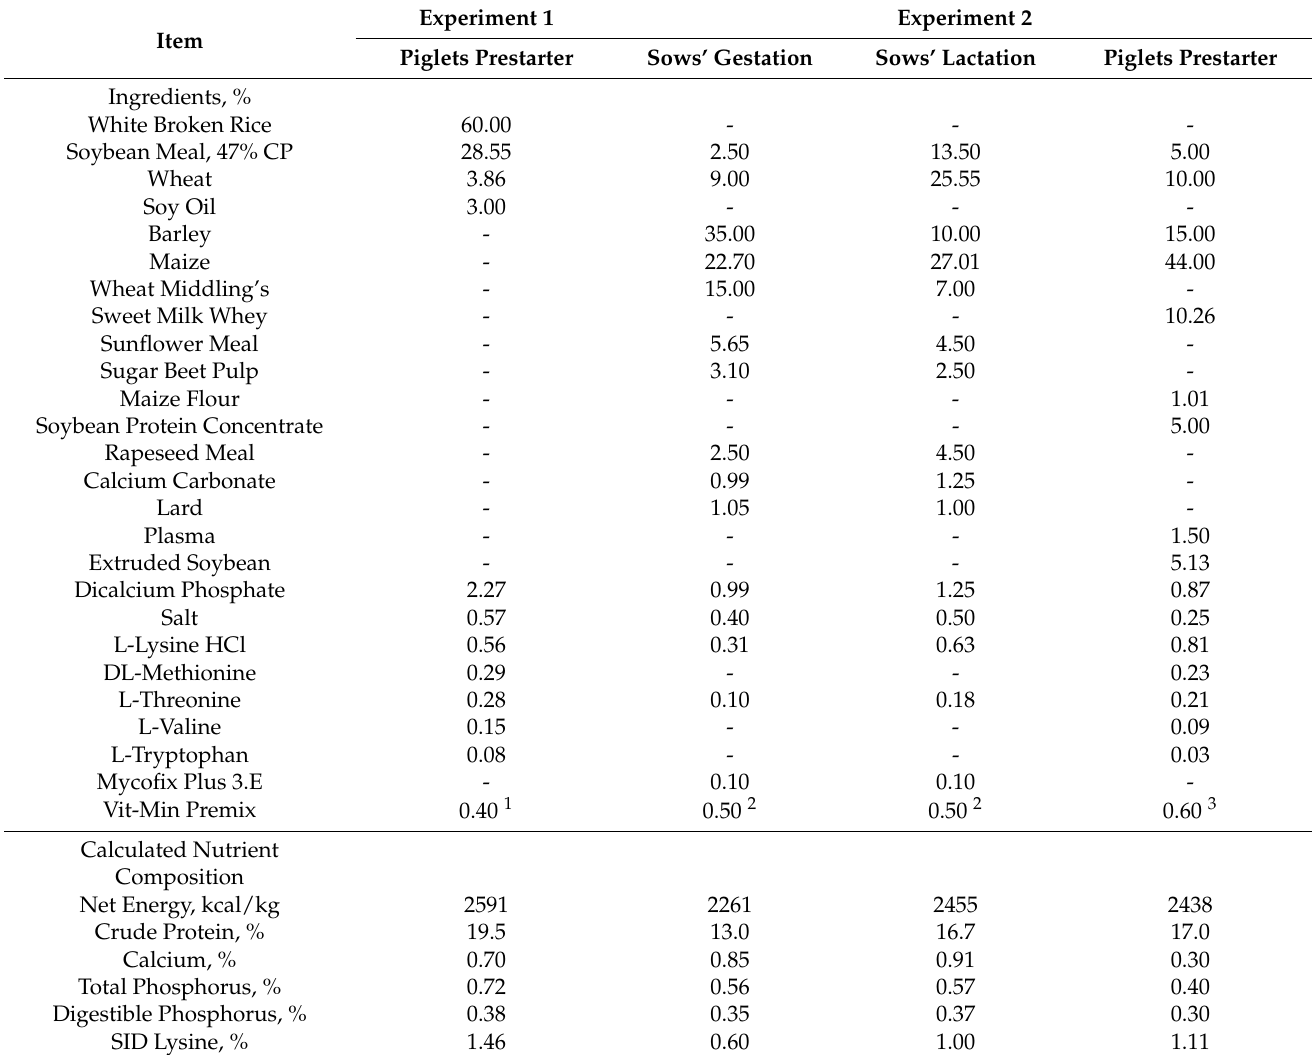
Table 1. Ingredients and nutrient composition of diets used in Experiment 1 and